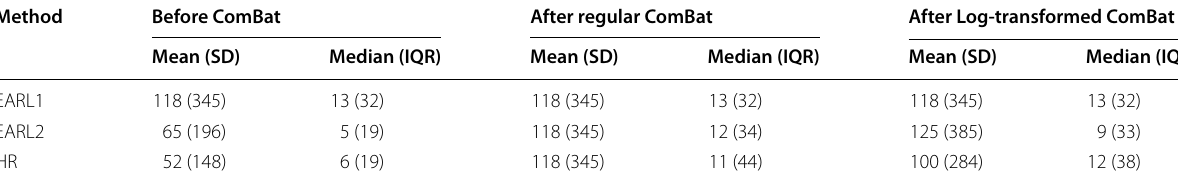
SD Standard Deviation, IQR Interquartile Range